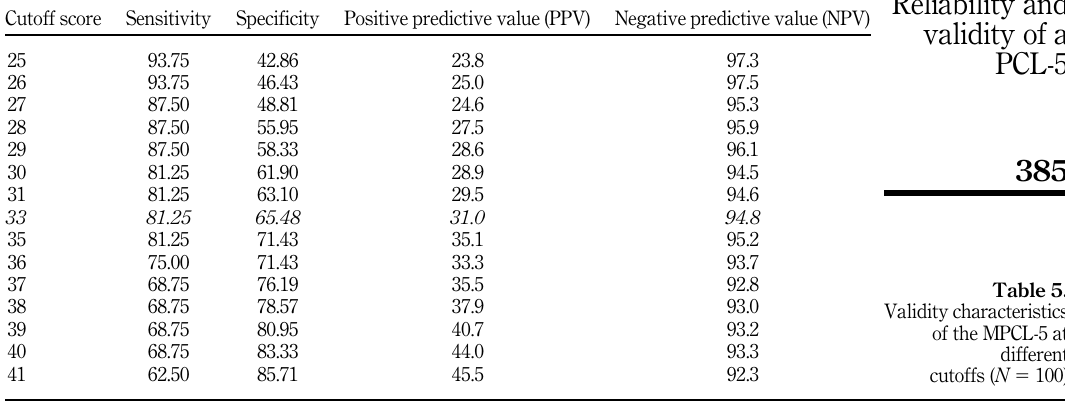
Table 5. Validity